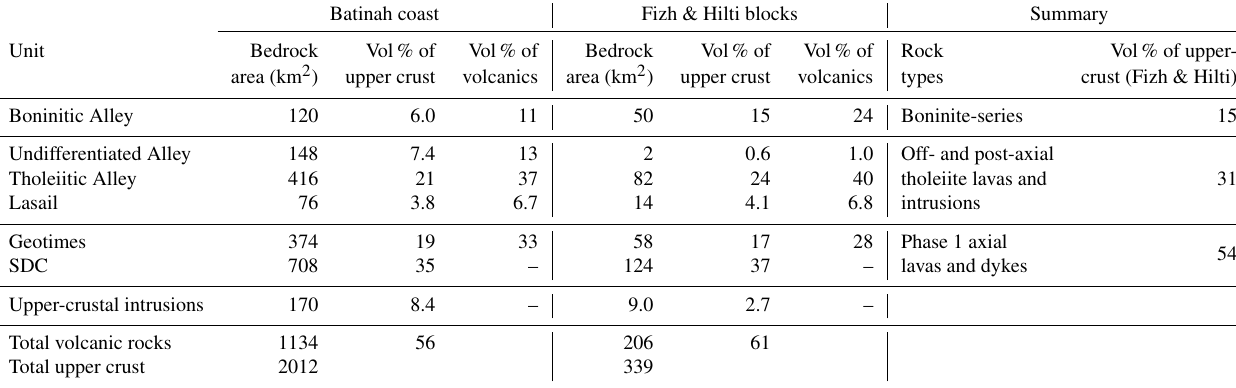
Table 2. Areal extents and inferred volumetric proportions of each Semail volcanic unit based on the bedrock map in Fig. 12 for both the Batinah coast and the structurally intact western Fizh and Hilti blocks. Proportions are given both as fractions of the volcanics and of the upper crust (including upper-crustal intrusions and the sheeted dike complex, SDC). Fizh & Hilti